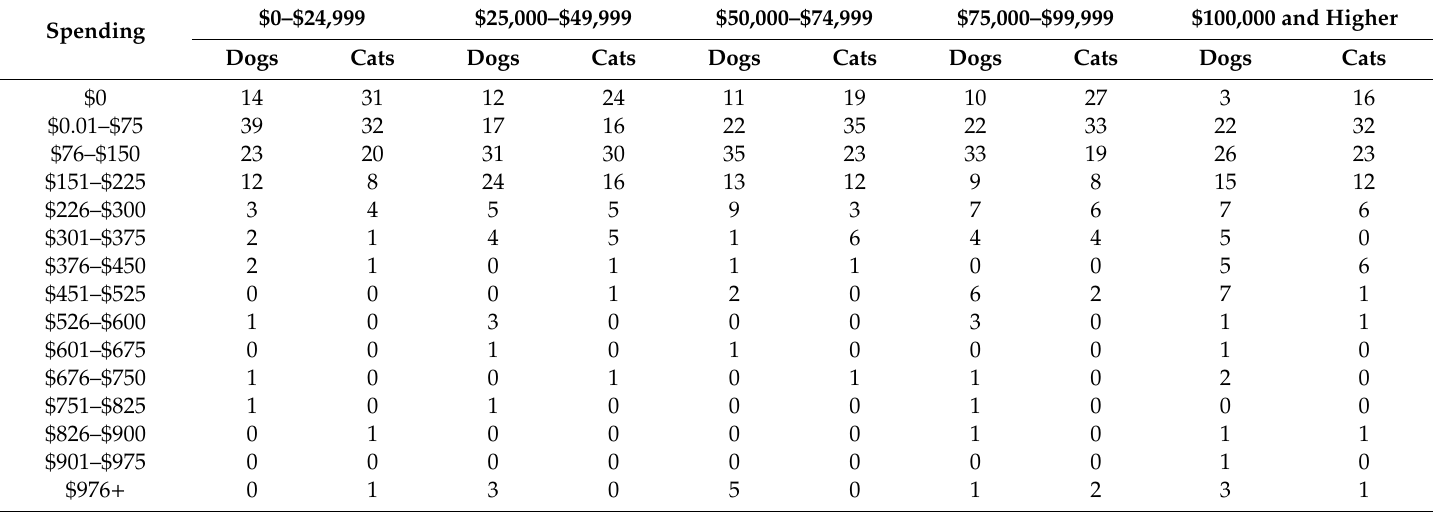
Table A7. Veterinary care spending by income categories